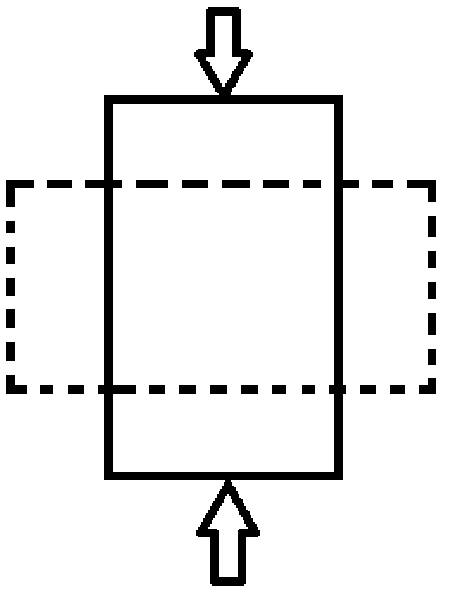
Figure 20. Length change of material under compression.